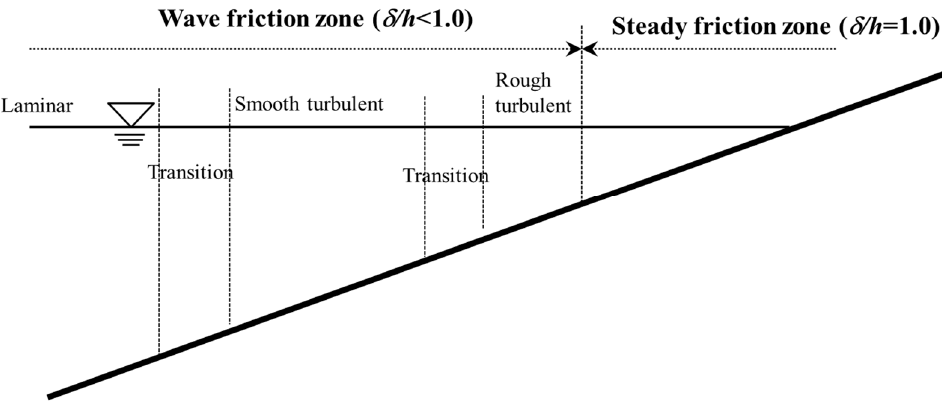
Figure 9. Transitional flow regime under the tsunami.